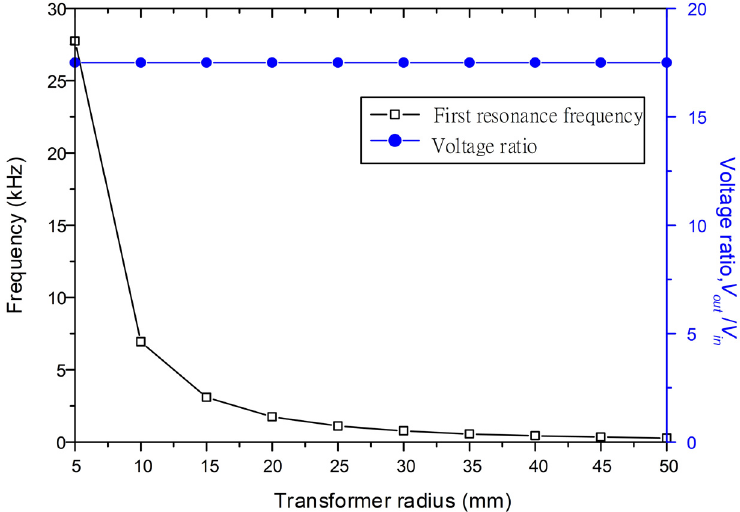
Figure 7. Effect of transformer radius on voltage ratios and first resonance frequencies.